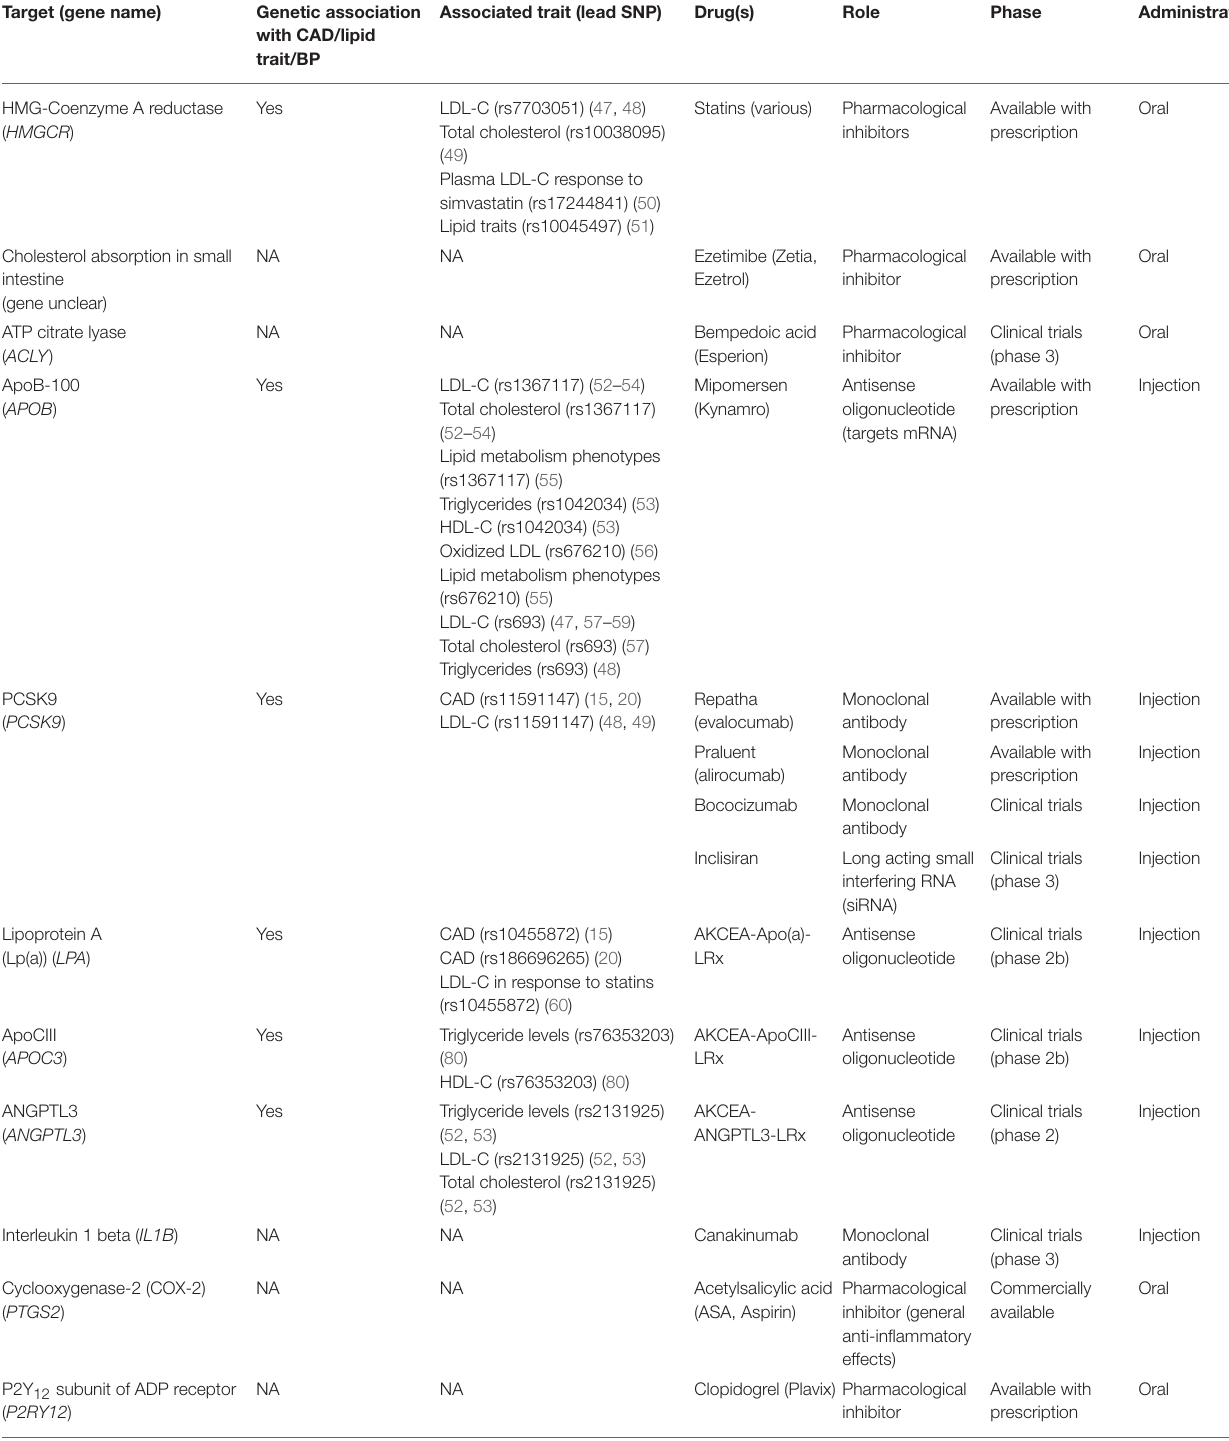
TABLE 1 | List of current target genes for management of coronary artery disease and their genetic